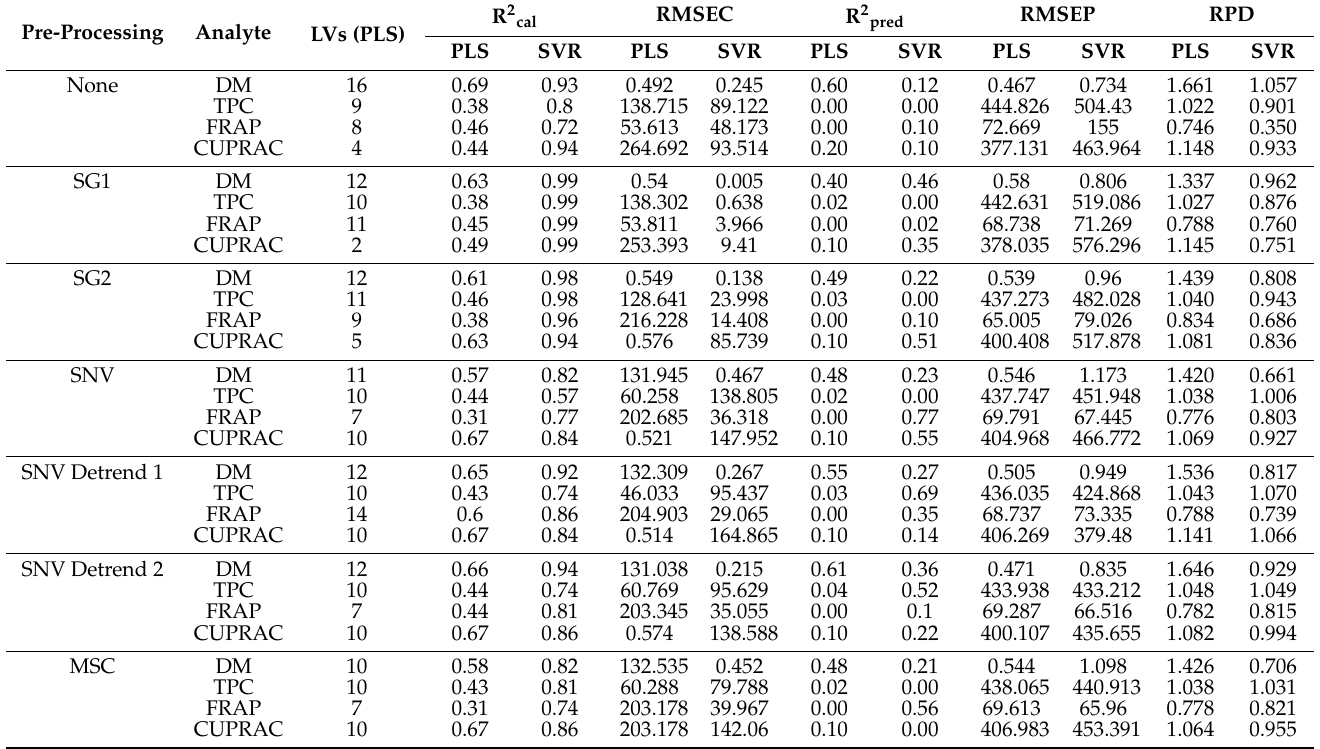
Table 5. Statistical parameters were obtained from the application of the PLSR and SVR algorithms on the combined NIR and MIR spectra datasets, using different pre-processing